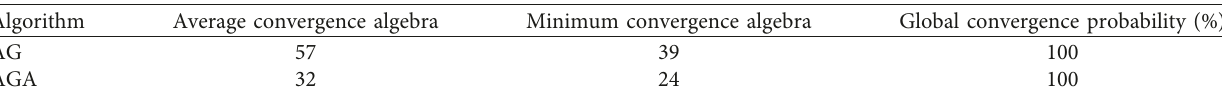
Table 7: Experimental